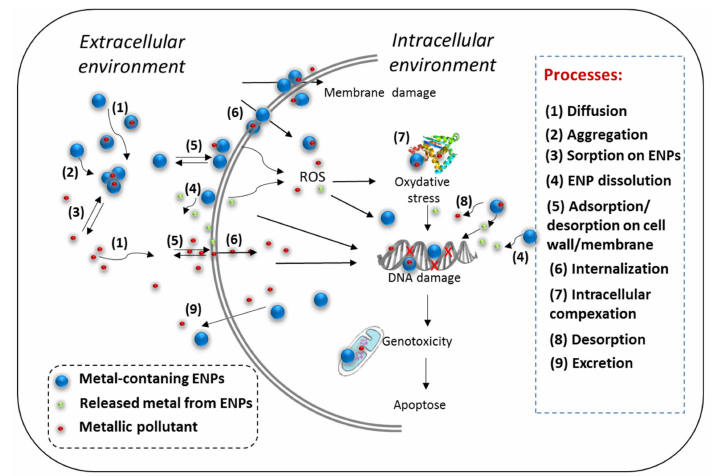
Figure 1. Schematic representation of key processes at the exposure medium—organisms’ interface, which govern the interactions in the mixtures of metal-containing engineered nanoparticles (ENPs) and metallic pollutants. Di ff erent forms of ENPs and metallic pollutants are transported towards the organism surface via di ff usion (1) . This process is size-dependent and di ff ers for metal ions, metal complexes, ENPs and aggregates. Once at the vicinity of the organism, di ff erent species are adsorbed (5) on the organisms’ surface. ENPs and their aggregates (and sorbed metallic pollutants) adhere on the cell walls and cell membrane. Then ENPs could penetrate (6) through the membrane (but not necessarily) by di ff erent pathways, including endocytosis for the case of “particle-ingestive” organisms, alteration in cell membrane permeability for the “particle-proof” organism or other possible mechanisms [7,13,22,23]. Dissolved metallic pollutants first adsorb to di ff erent sites of the organism surface. Next, they could cross the membrane by facilitated (e.g., via channel mediated di ff usion) or active (e.g., through the essential trace metal transporters) transport. Once inside the cell, ENPs and metallic pollutants interact with intracellular structures and biomolecules, such as proteins, lipids and DNA, and could a ff ect vital cellular processes; ENPs or metallic pollutants can be transformed (8) via di ff erent processes such as intracellular complexation, dissolution of ENPs, sulfidation or excreted (9). The complex interplay between all the processes will determine the overall e ff ect of the mixture of ENPs and metallic